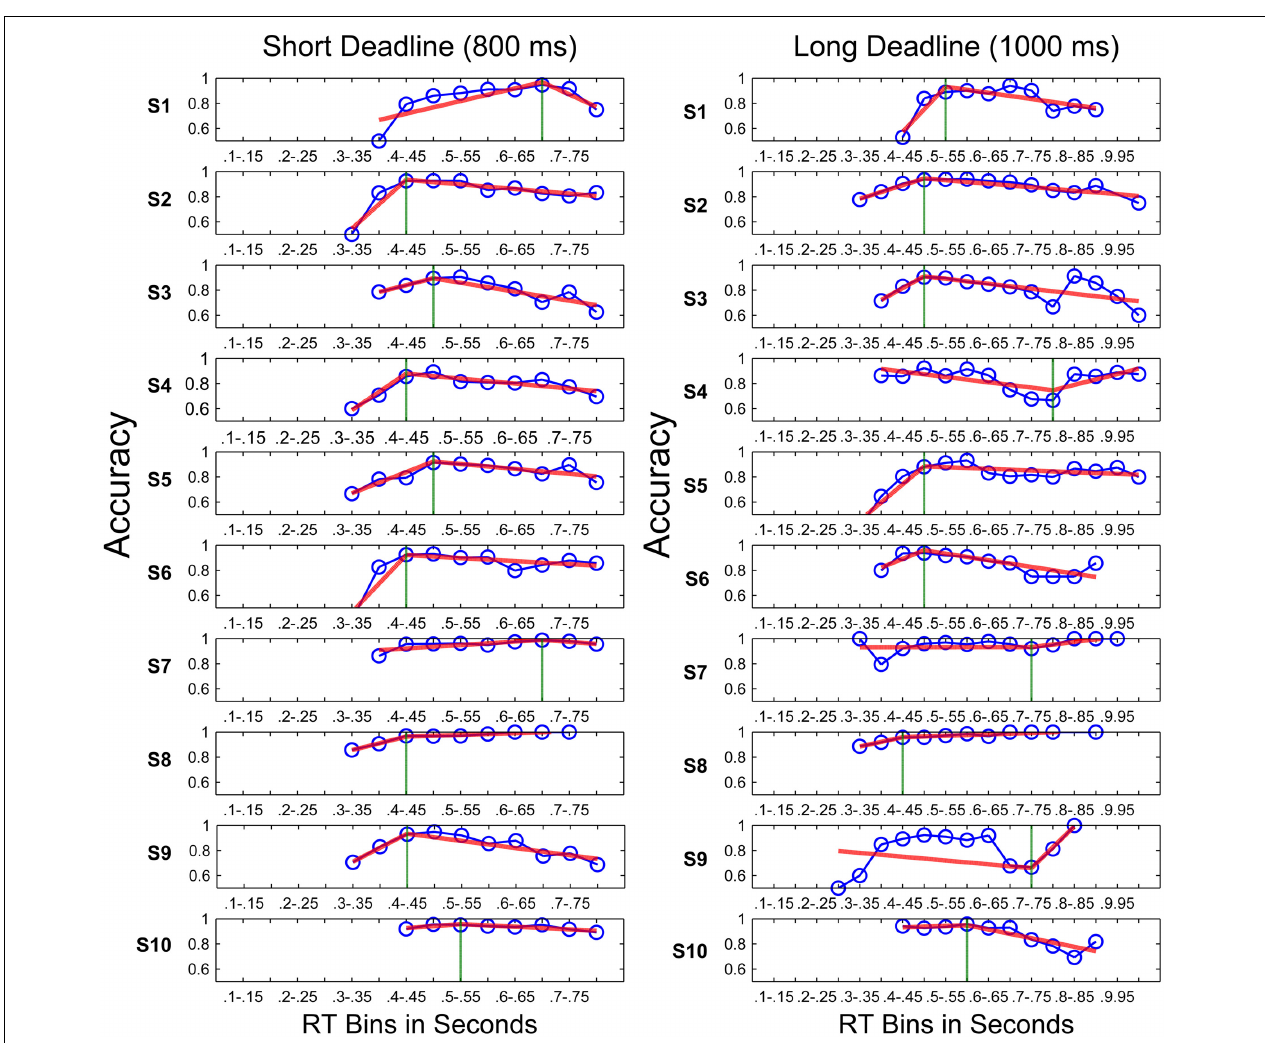
FIGURE 9 | Piece-wise linear fits (red lines) to conditional accuracy for the DR blocks (blue lines with circles) of all participants in the short deadline (left) and long deadline (right) conditions. Vertical green lines indicate inflection points.